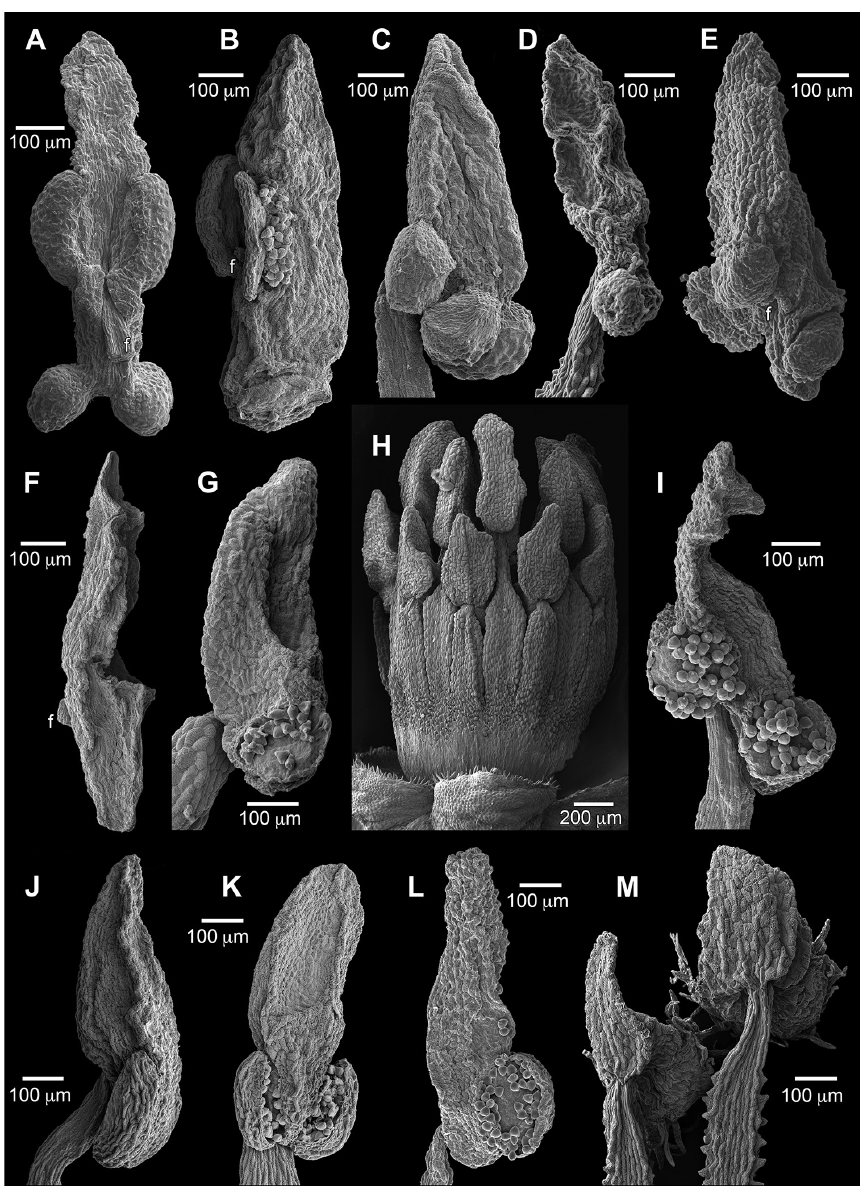
Figure 1 . Stamen structure of Humiriaceae. A Duckesia verrucosa tetrasporangiate anther, dorsal B Duck- esia verrucosa tetrasporangiate anther, lateral C Duckesia liesneri tetrasporangiate anther, lateral D En- dopleura uchi disporangiate anther, lateral E Endopleura uchi tetrasporangiate anther, lateral F Duckesia verrucosa sterile anther, lateral G Humiriastrum cuspidatum disporangiate anther, lateral H Humiriastrum cuspidatum androecium, dorsal I Endopleura uchi tetrasporangiate anther, lateral J Humiriastrum dentat- um disporangiate anther, lateral K Humiriastrum dentatum disporangiate anther, ventral L Humiriastrum diguense disporangiate anther, lateral M Humiria balsamifera var. imbaimadaiensis stamen cluster with 2 of 3 types, dorsal. f = filament attachment location. Sources: A, B, F Ducke 2108 C Henderson 933 D, E, I Assunção 605 G, H Cid et al. 4264 J, K Hatschbach 56145 L Quizhpe et al. 612 M Wurdack 4814 (all